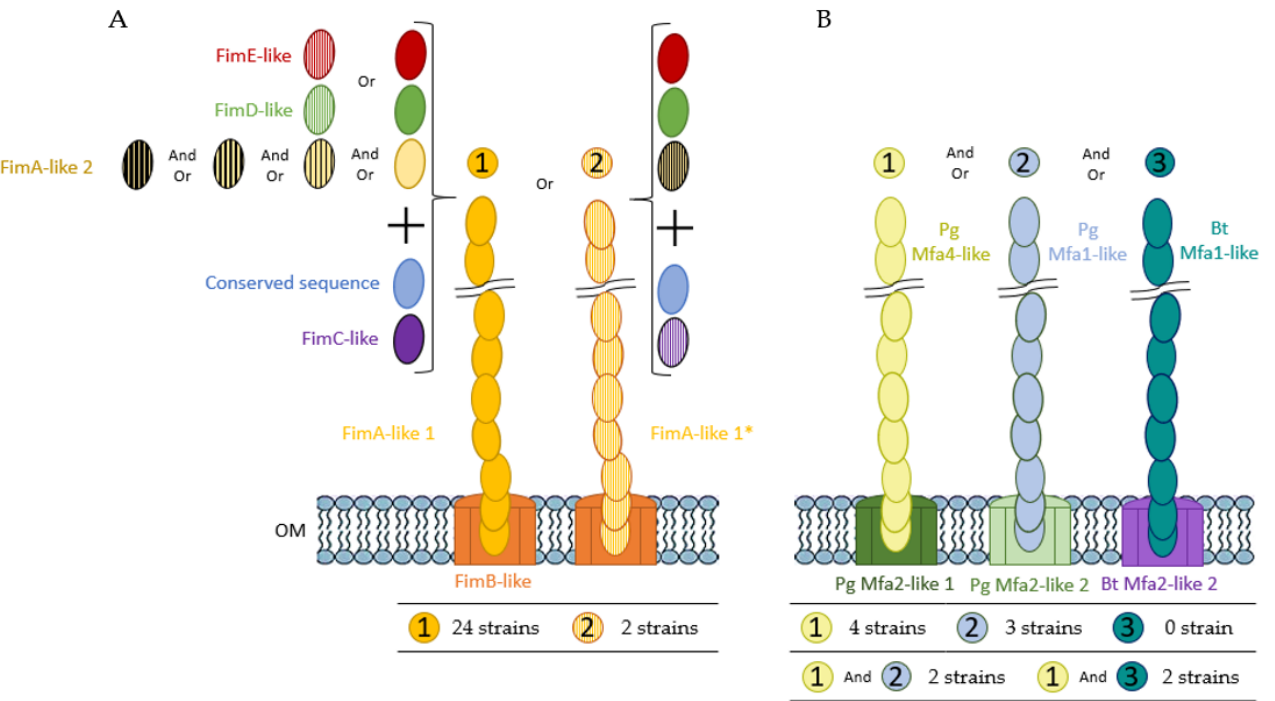
Figure 6. Hypothetical schematic representation of P. distasonis ( A ) fimbriae and ( B ) pili from the Fim and Mfa system, respectively. The different type of fimbriae and pili have been identified from 1 to 2 and from 1 to 3, respectively. The table below each structure represents the number of strains harboring the gene cluster encoding the hypothetical structure. The color code corresponds to the syntenic analysis. “Or” indicates that one P. distasonis strain can harbor only one of the proteins encoding genes concerned. For example, type 1 Fim cluster of P. distasonis contains either fimE -like or striped fimE -like genes but never both in the 24 identified clusters. “And Or” indicates that one P. distasonis strain can harbor one or several of the protein encoding genes. For example, various fimA -like 2 genes combinations can be found within type 1 Fim cluster of P. distasonis .